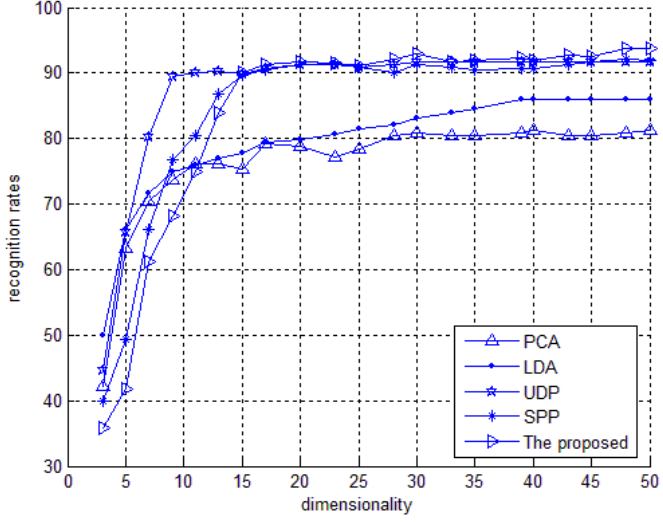
Figure 2. Recognition rates vs . dimensionality on ORL